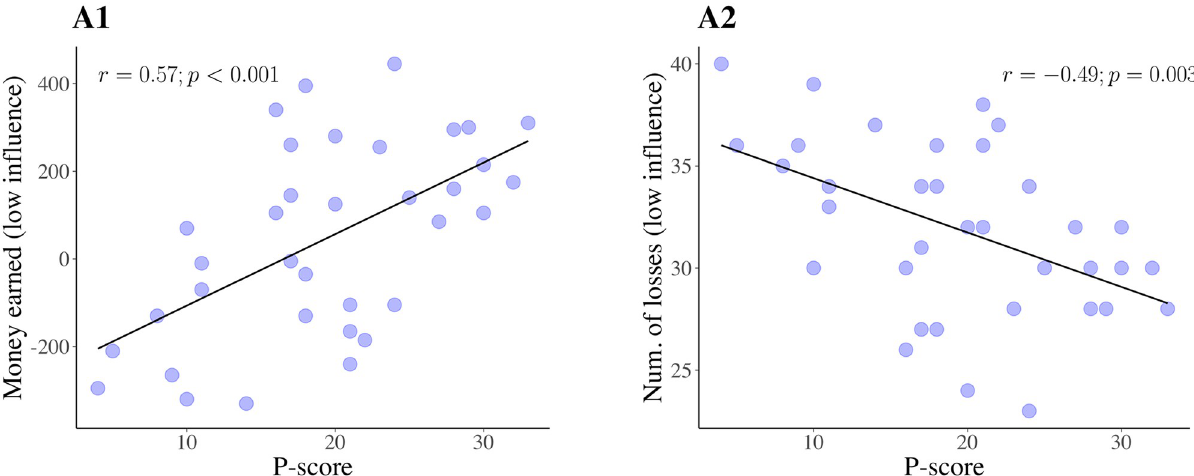
Fig 8. P-scores and performance in low influence conditions. Plots illustrating ( A1 ) the positive correlation between P-scores and money earned, and ( A2 ) the negative correlation between P-scores and number of losses, in low influence trials.